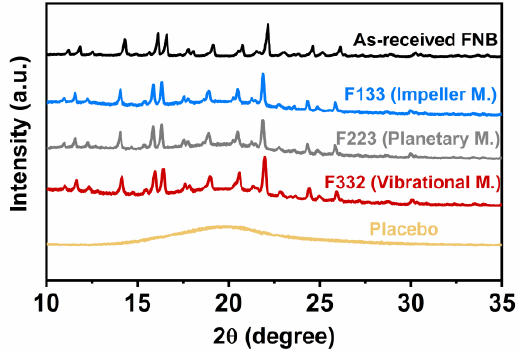
Figure 2. XRD patterns of AR-FNB powder, placebo film, and the films containing ~23 wt% FNB concentration processed with the mixing conditions of F133, F223, F332.